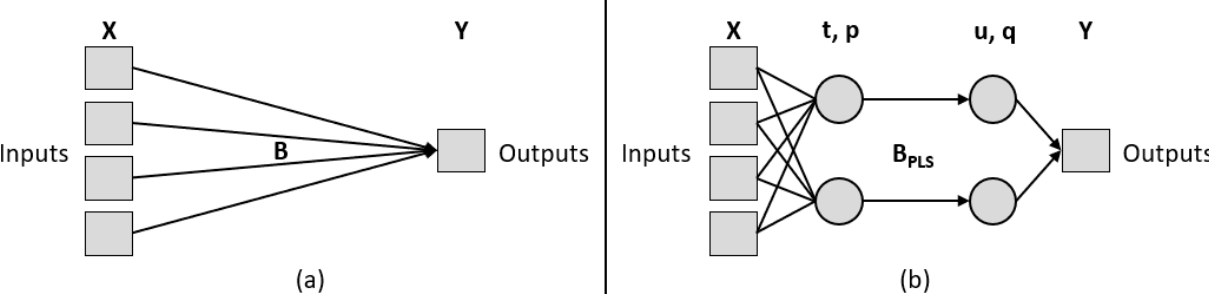
Figure 3. Simplified schematic comparison of multiple linear regression (MLR) and partial least squares (PLS) regression methods. ( a ) MLR uses all original variables to directly form a linear combination via the normal equations; ( b ) PLS first transforms the original variables by projecting to latent structures (linear combinations) that maximize covariance (orthogonality) between the new variables ( 𝐭 and 𝐮 ) (modified after [50].